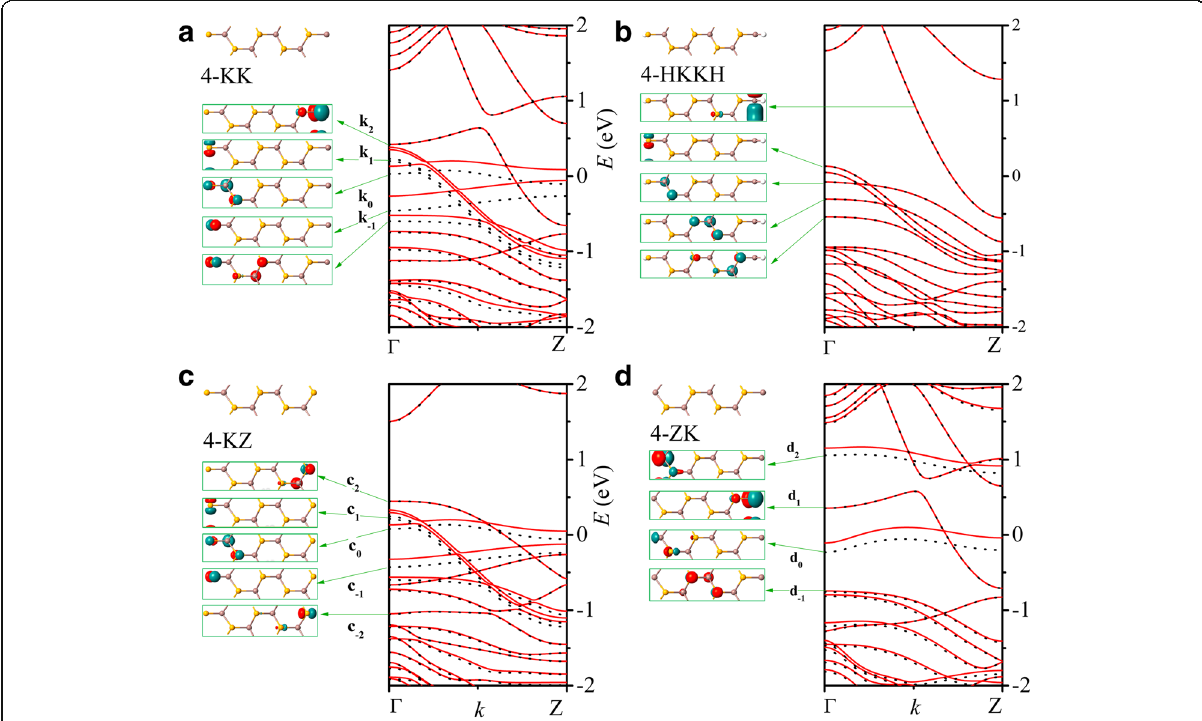
Fig. 4 The band structures and Γ -point Bloch states of 4-KK ( a ), 4-HKKH ( b ), 4-KZ ( c ), and 4-ZK ( d )